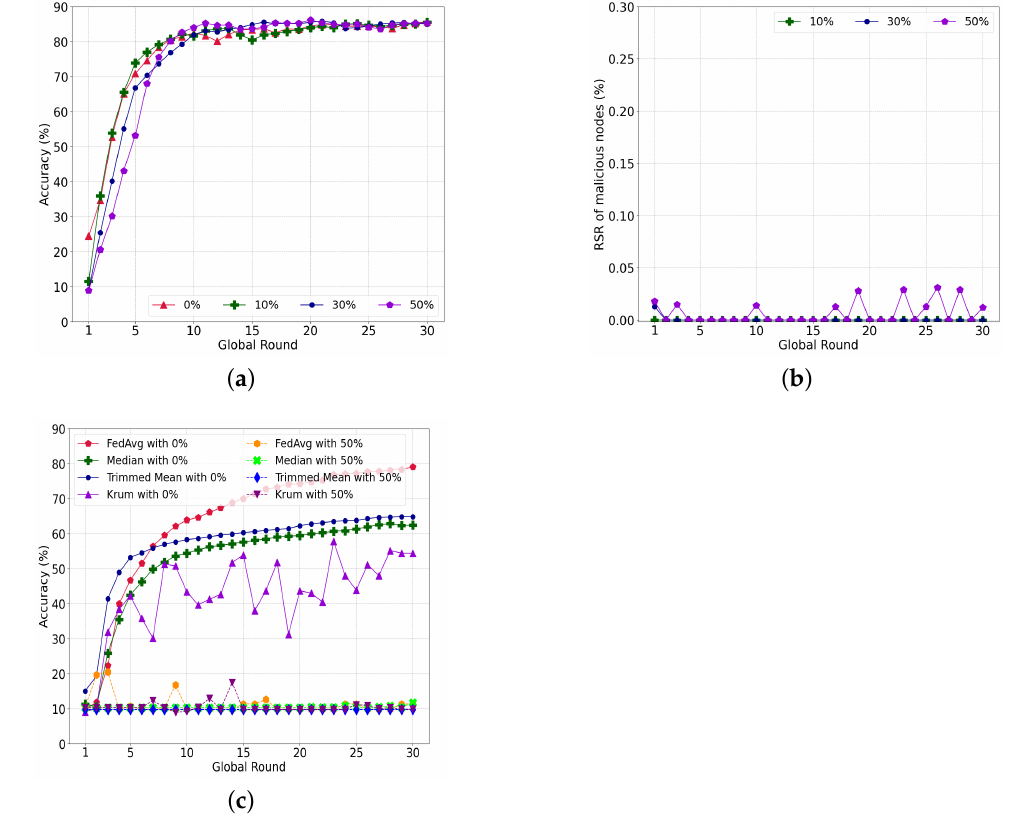
Figure 10. Evaluation of our system with a model-poisoning attack. ( a ) Performance of the proposed system; ( b ) RSR with varying ratio of attackers; ( c ) Performance comparison of FedAvg , Median TrimmedMean and Knum